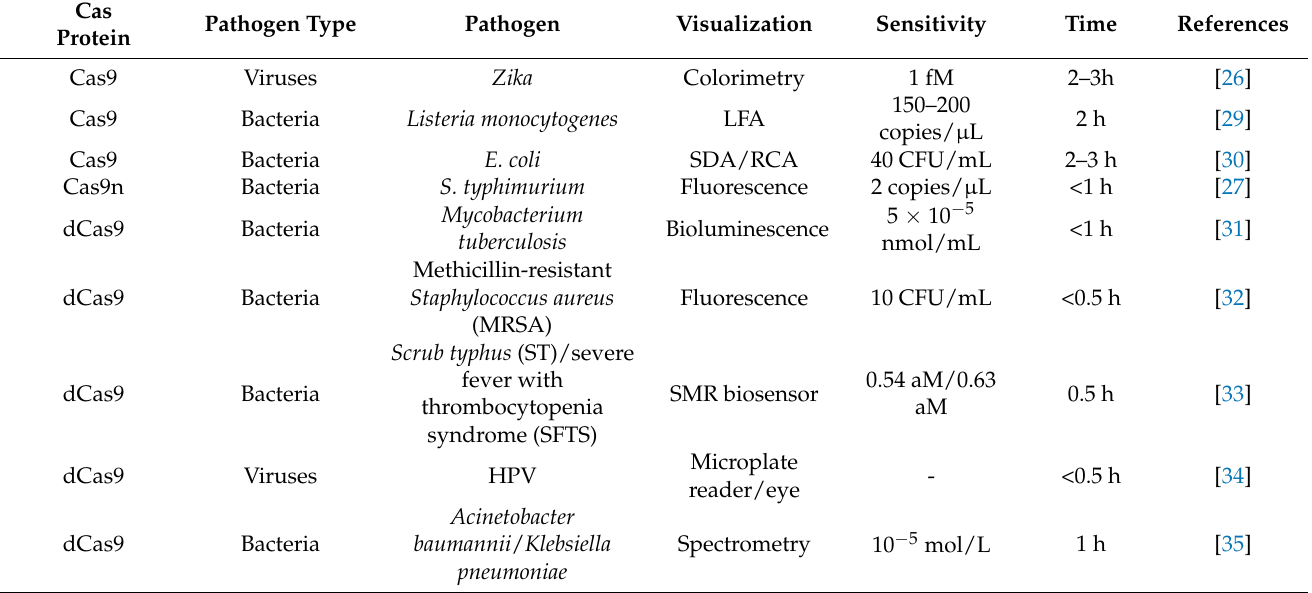
Table 1. More applications of CRISPR/Cas9 in pathogen